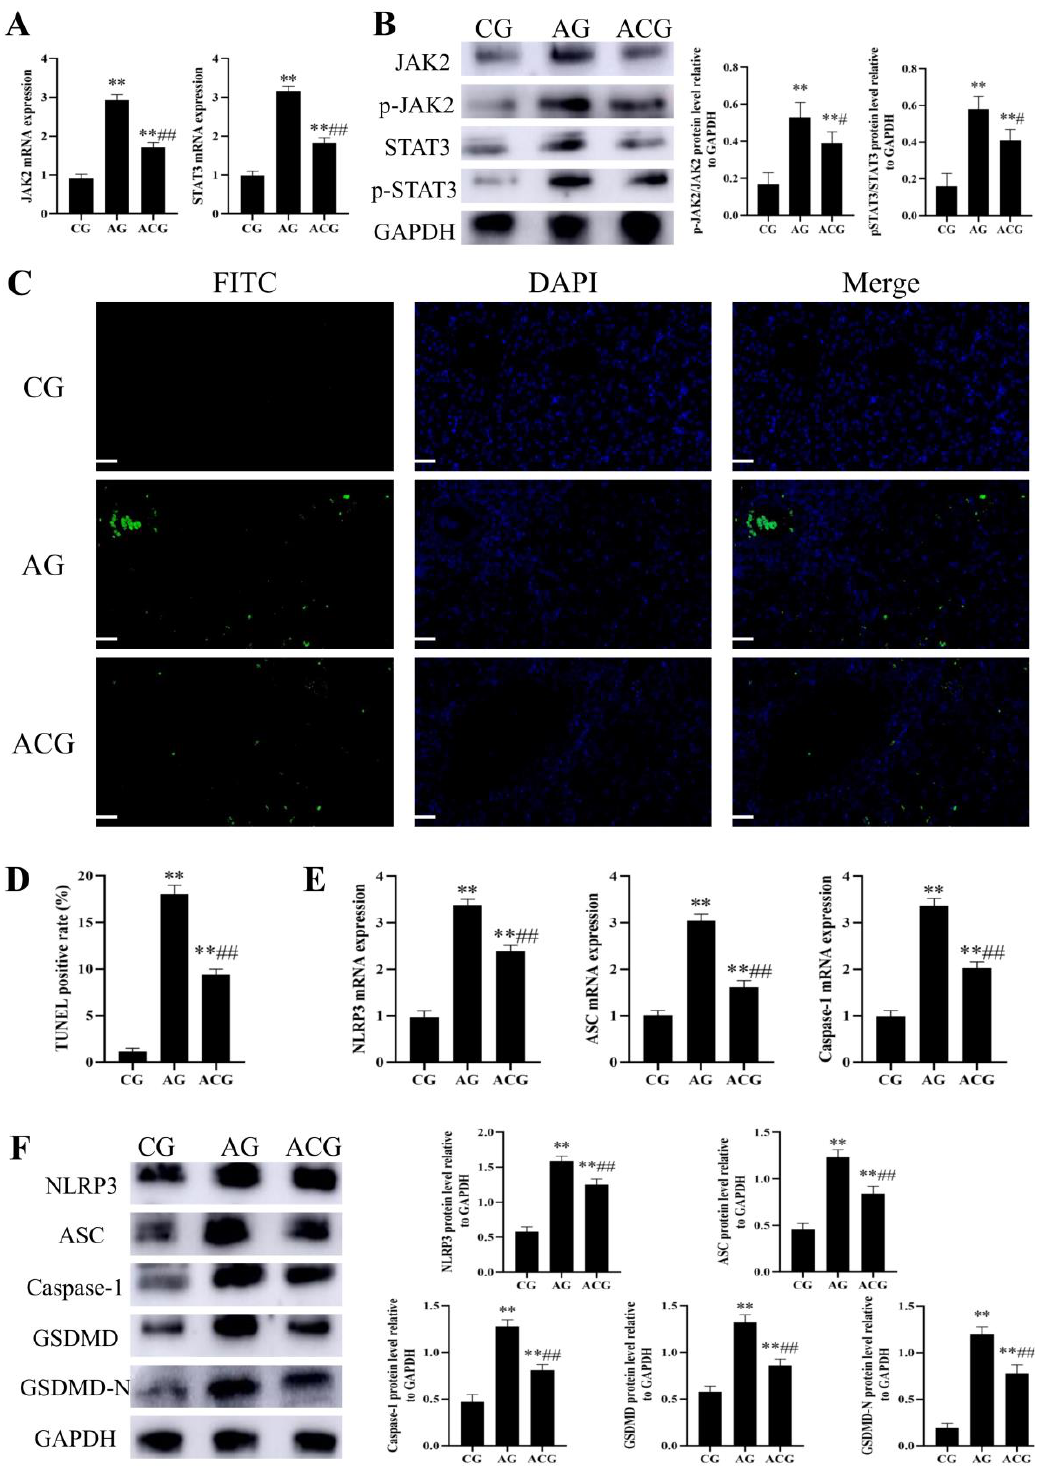
Figure 6. Curcumin inhibited JAK2/NLRP3-mediated pyroptosis of duck livers caused by AFB 1 . ( A ) mRNA expressions of JAK2 and STAT3 ( n = 6). ( B ) Western blot of the JAK2, p-JAK2, STAT3, and p-STAT3 protein ( n = 3). ( C ) Representative images of liver TUNEL staining. Scale bar: 50 μm. ( D ) TUNEL analysis of livers ( n = 3). ( E ) mRNA expressions of IL- 1β and IL-18 ( n = 6). ( F ) Western blot analysis of the NLRP3, ASC, Caspase-1, GSDMD, and GSDMD-N protein levels ( n = 3). ** p < 0.01 vs. the CG. # p < 0.05 and ## p < 0.01 vs. the AG.